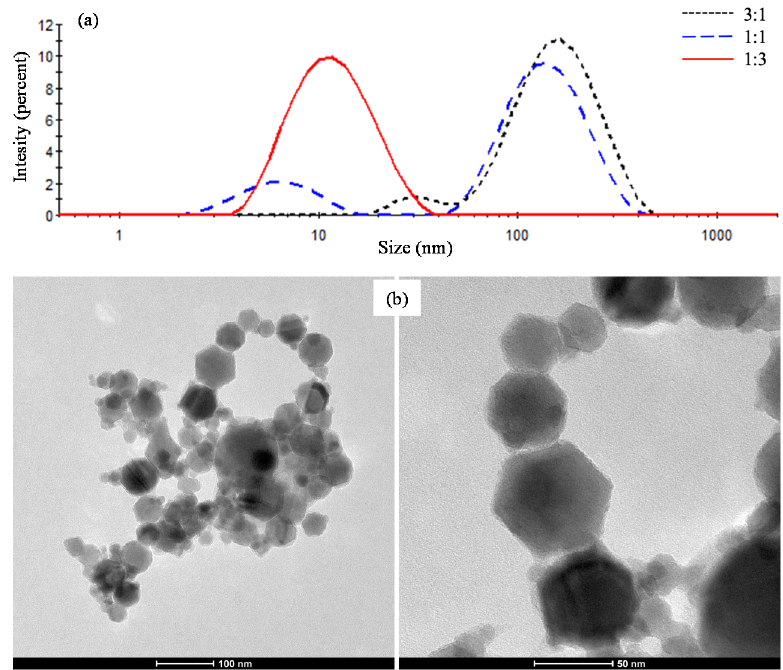
Figure 2. ( a ) Particle size distributions of N-doped C-Dots by DLS measurements and ( b ) TEM images of N-doped C-dots with 1:3 CA:PVAm ratio.